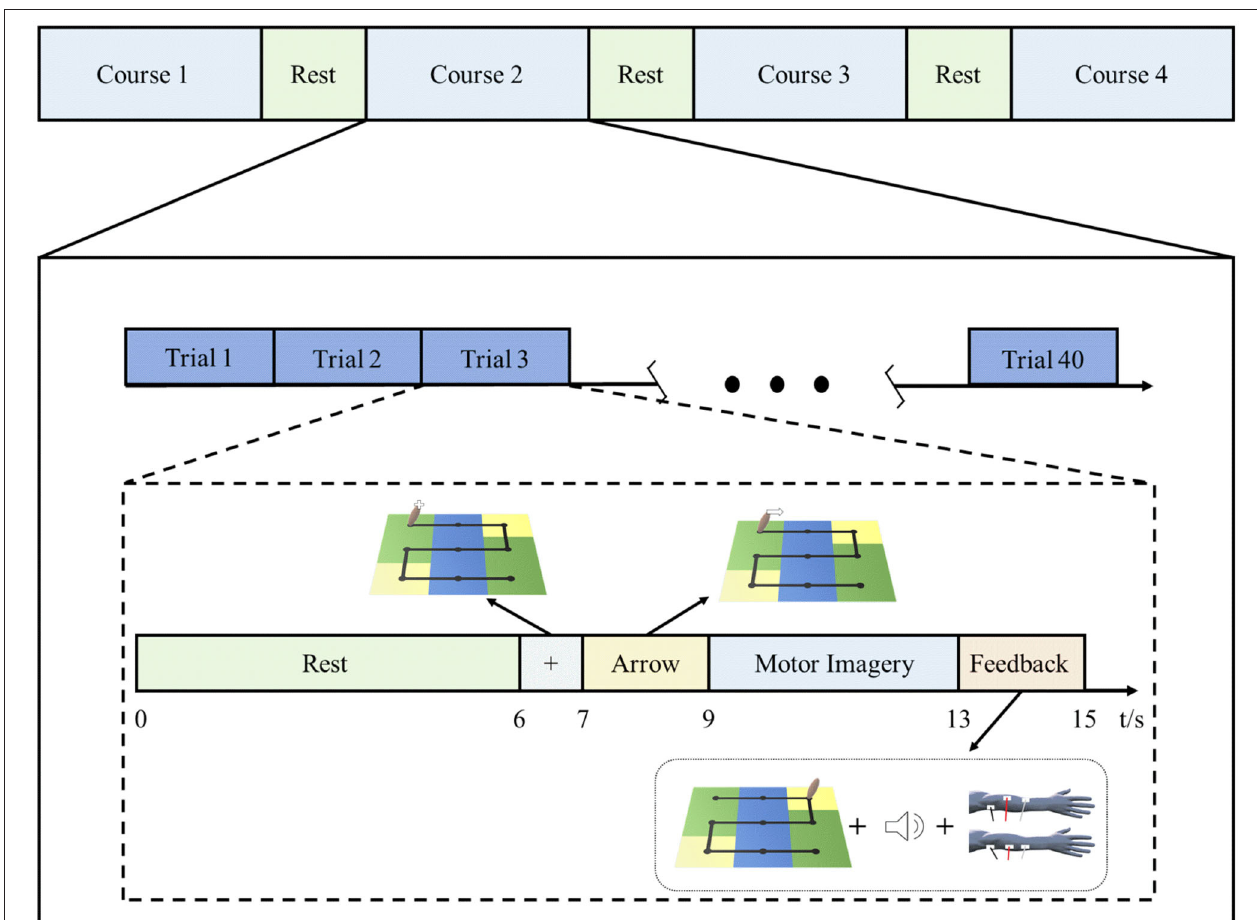
FIGURE 2 | Rehabilitation training protocol of the BCI–FES